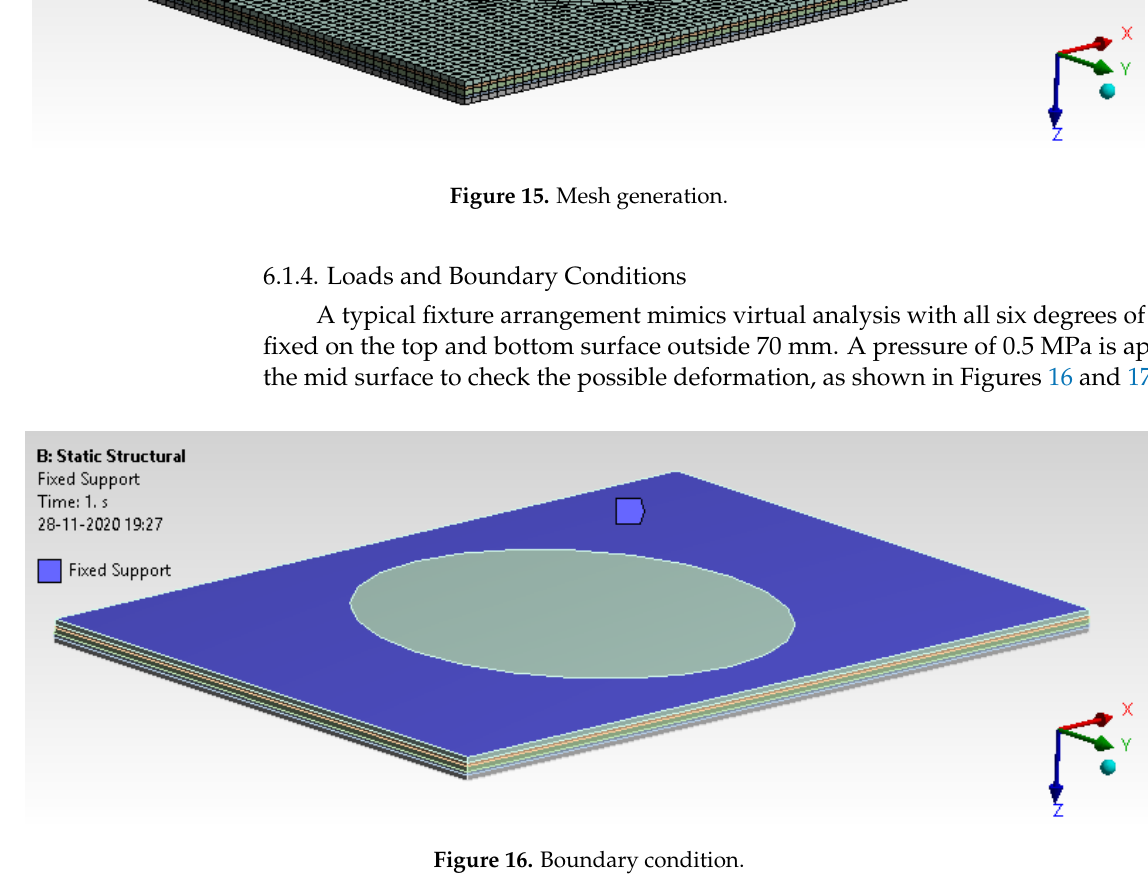
Figure 16. Boundary condition.